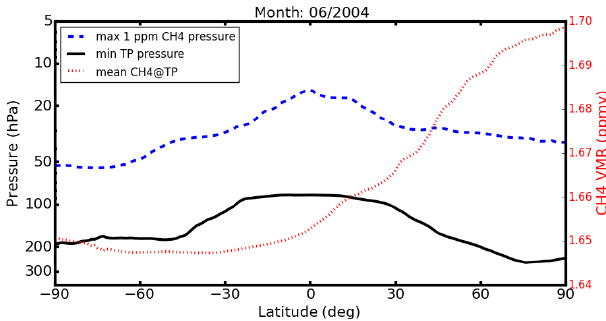
Figure 9. Zonal minimum of tropopause pressure, zonal maxi- mum of 1ppmv CH 4 pressure and zonal mean of CH 4 VMR at tropopause (right y axis) for June 2004 of the OH-chem simulation (see Sect. 6). The 1ppmv CH 4 pressure in each column is calculated as the air pressure of the model layer where CH 4 VMR decreases below